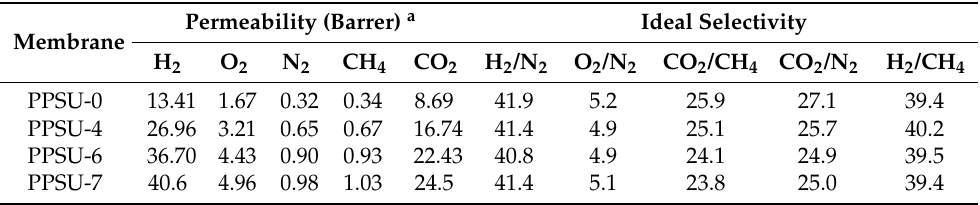
Table 3. Pure gas permeation properties of copolymers (tested at 35 ◦ C and a transmembrane pressure of 2 atm, less than 10% deviation).